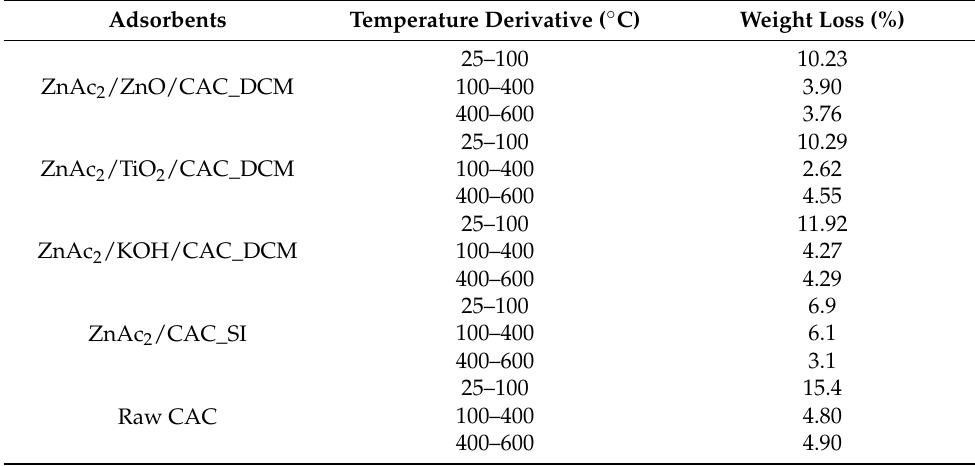
Table 3. Weight loss (%) for temperature derivatives in TGA for fresh DCM/CAC, SI/CAC, and raw CAC